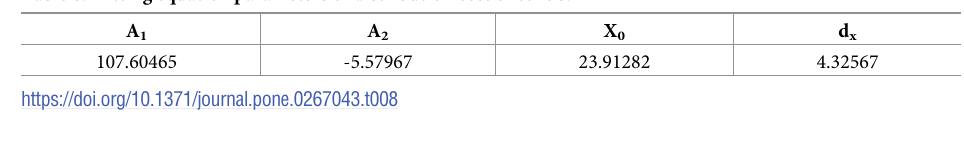
Table 8. Fitting equation parameters of distribution cost of